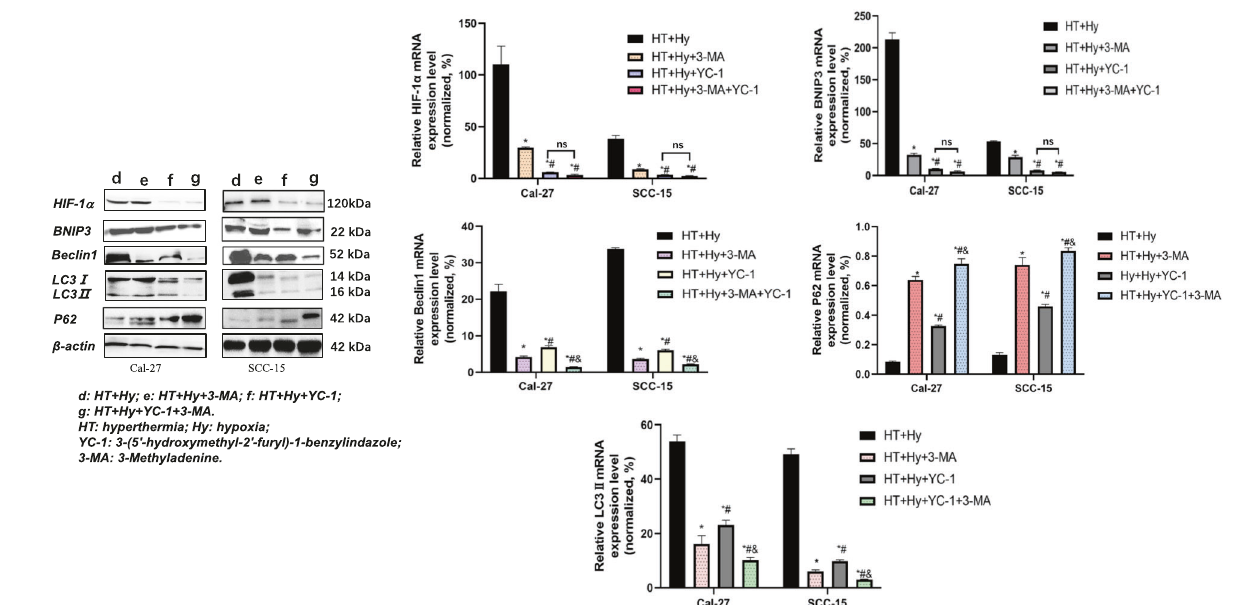
Fig. 5 The addition of YC-1 and 3-MA inhibited HT-induced autophagy in hypoxia and starvation tumor microenvironment, both of which involved downregulation of the HIF-1 α /BNIP3 /Beclin1 signaling pathway. The mRNA and protein expression of HIF-1 α , BNIP3, Beclin1, LC3-II, and p62 in OSCC cells were measured by Western blot and qRT-PCR, which were normalized to β -actin. The results were presented as the mean ± standard deviation of three independent experiments. d: HT + Hy; e: HT + Hy + 3-MA; f: HT + Hy + YC-1; g: HT + Hy